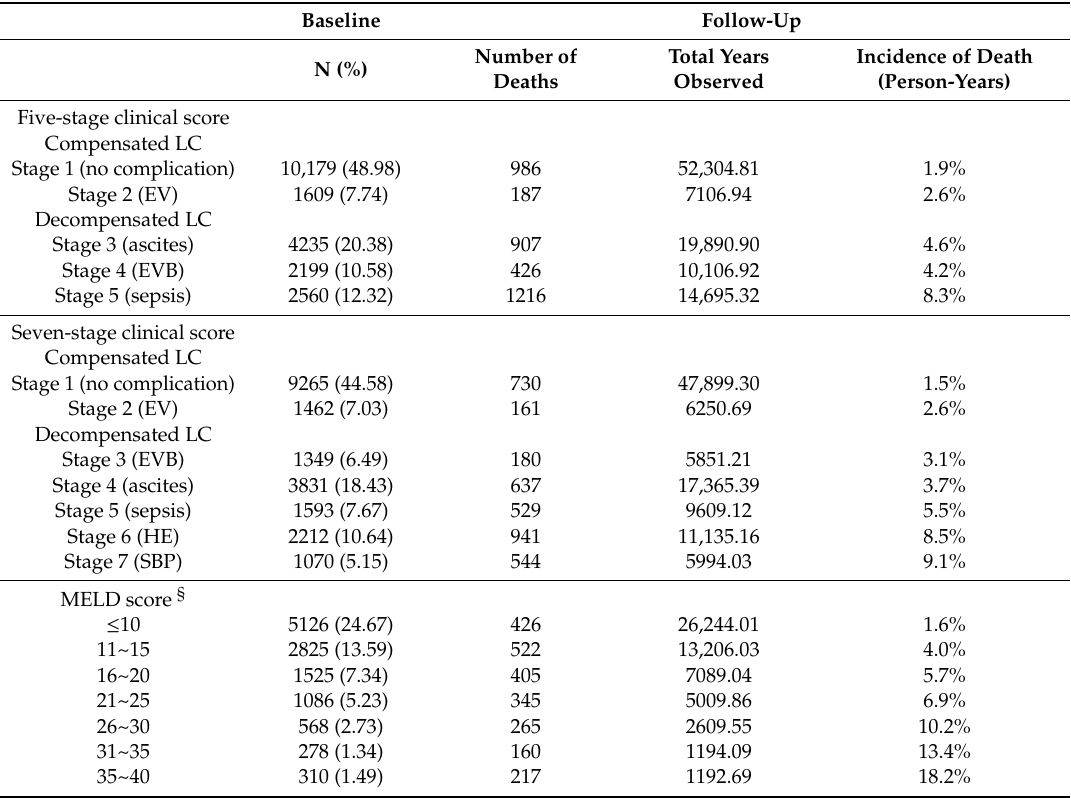
Table 3. The incidence rates of death (person-years) for each clinical stage and MELD score. Baseline Follow-Up Number of Total Years Incidence of Death N (%) Deaths Observed